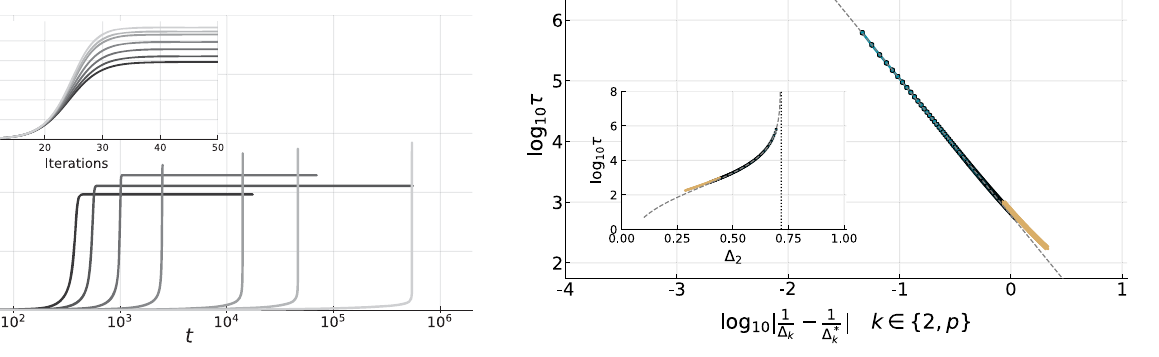
¯ C ð t Þ starting FIG. 3. Extrapolation of the Langevin relaxation time. The inset presents the relaxation time for fixed Δ presents a fit using a power law consistent with a divergence at ). p Δ (cid:1) ≈ 0 . 72 . The circles are obtained with a numerical solution of 2 LSE that uses the dynamical grid, while crosses are obtained using a fixed grid; the initial condition is (details are given in Appendix